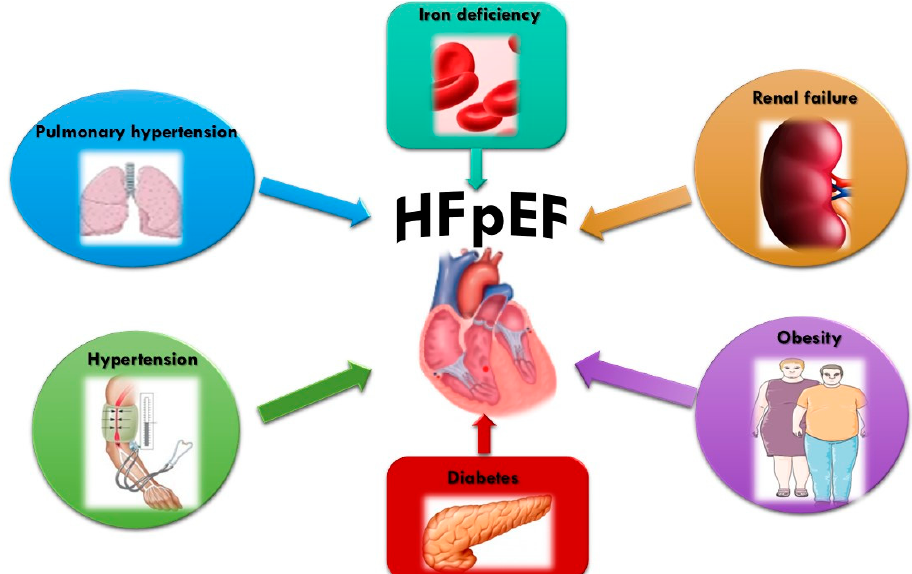
Figure 1. The influence of comorbidities on the development of HFpEF. Iron deficiency, diabetes mellitus, obesity, renal failure, hypertension, and pulmonary hypertension increase the risk of HFpEF through structural and functional cardiac change, and systemic inflammation.